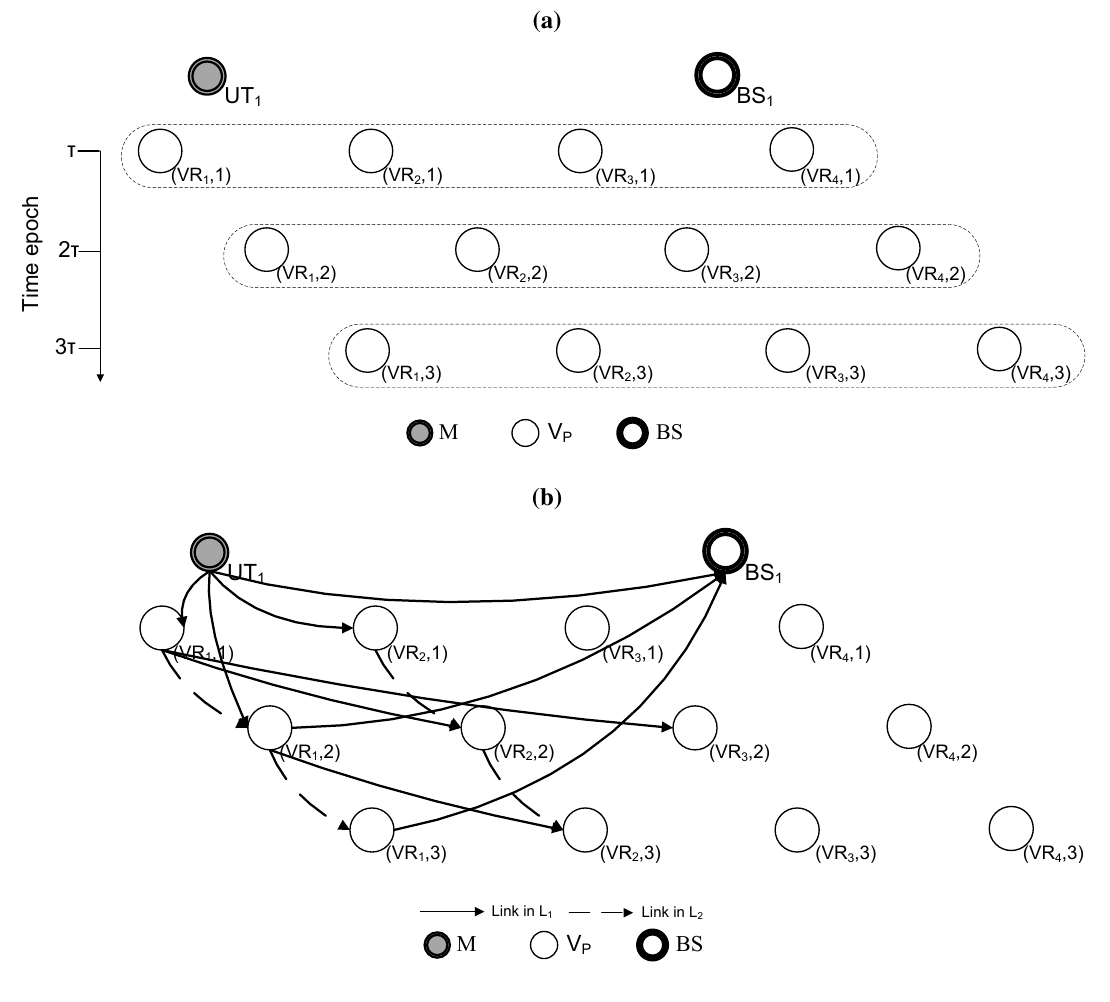
Figure 4. Space-time network for the network model under investigation. (a) The time-expanded network captures node positions at future time instances. Node replication is done every (cid:28) units of time; (b) Connected graph with both transmission and store-carry and forward links.